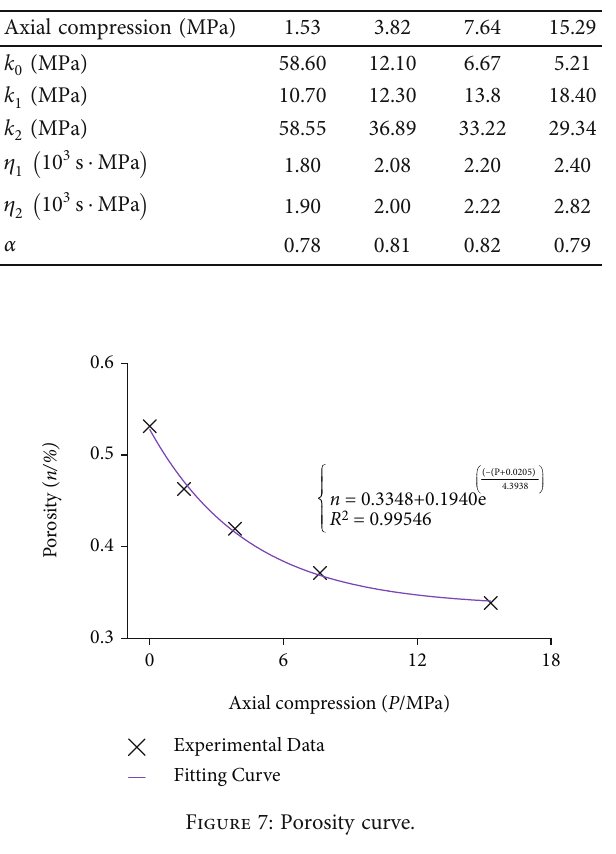
Figure 7: Porosity curve.